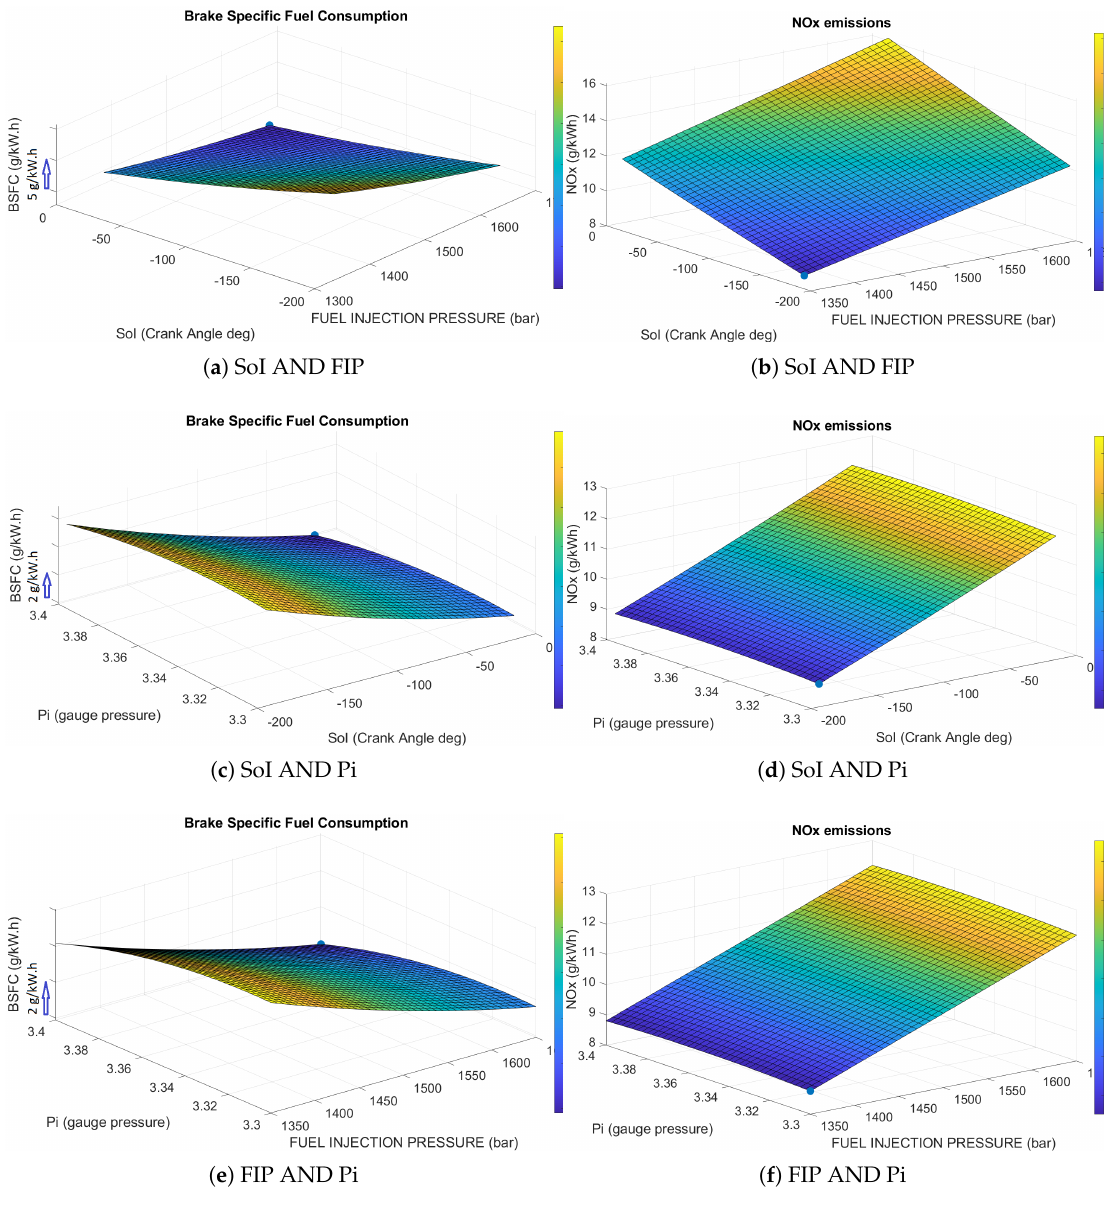
Figure A4. Response surface of the BSFC & NO x at 1000